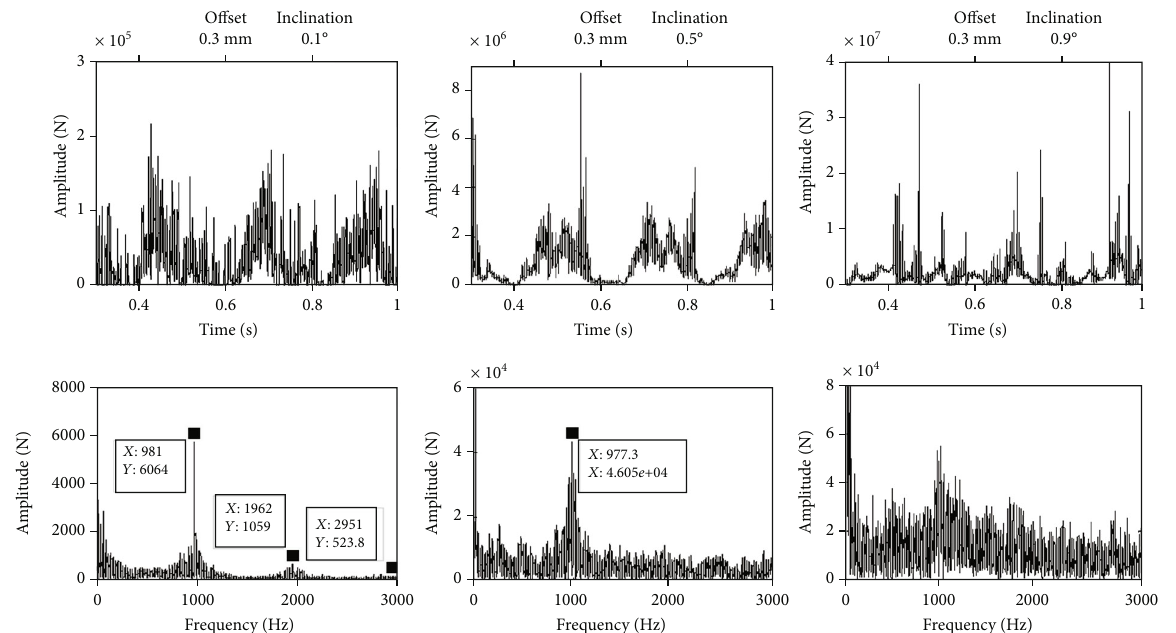
Figure 8: The time domain diagram and frequency spectrum diagram of the meshing force between the sun gear and the planetary gear at di ff erent angle inclination positions.